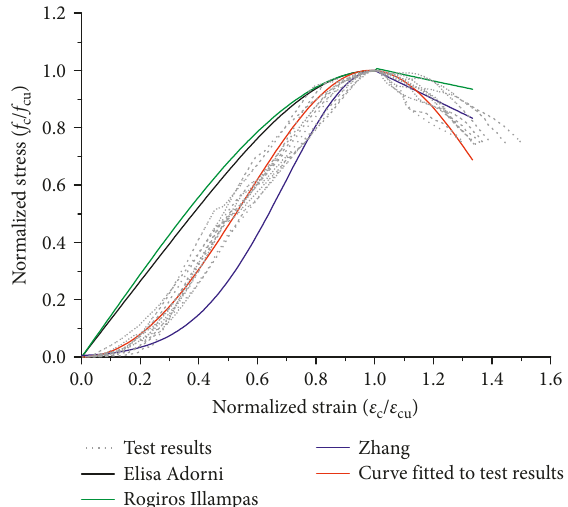
Figure 12: Normalized stress-strain test results obtained from compression tests on ten cubic specimens. The curves fitted to these data are compared to other three models.